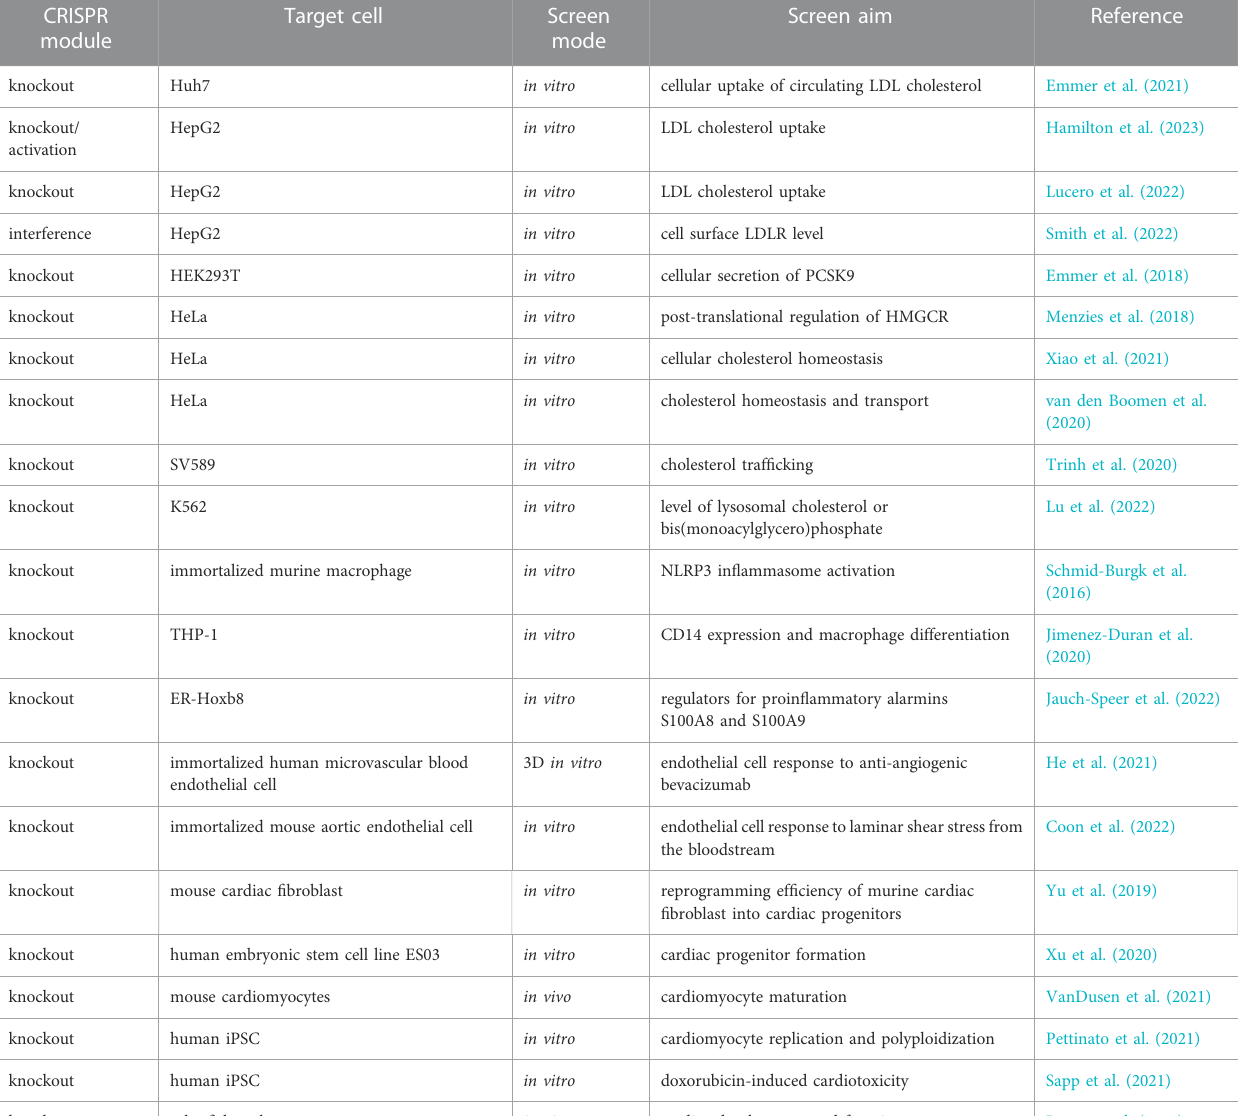
TABLE 1 List of pioneer studies performing CRISPR screen in cardiovascular